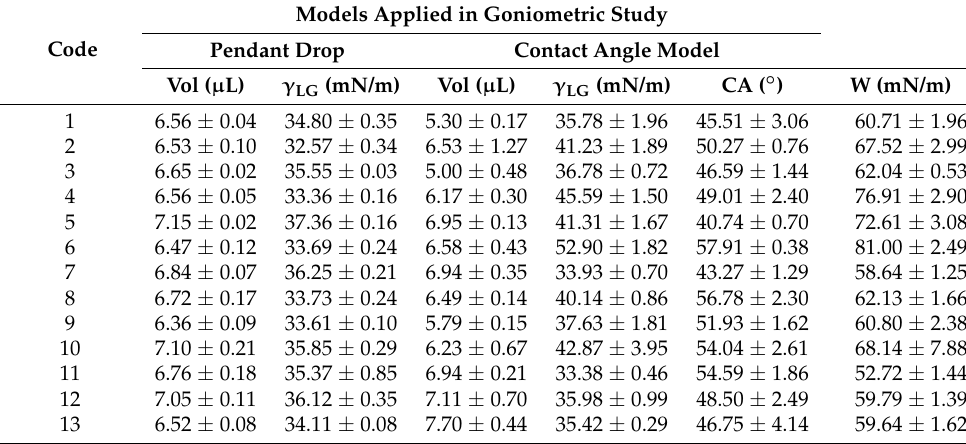
Table 5. Superficial parameters of microemulsions, explored during goniometric analysis at 25 ± 0.5 ◦ C. Models Applied in Goniometric Code